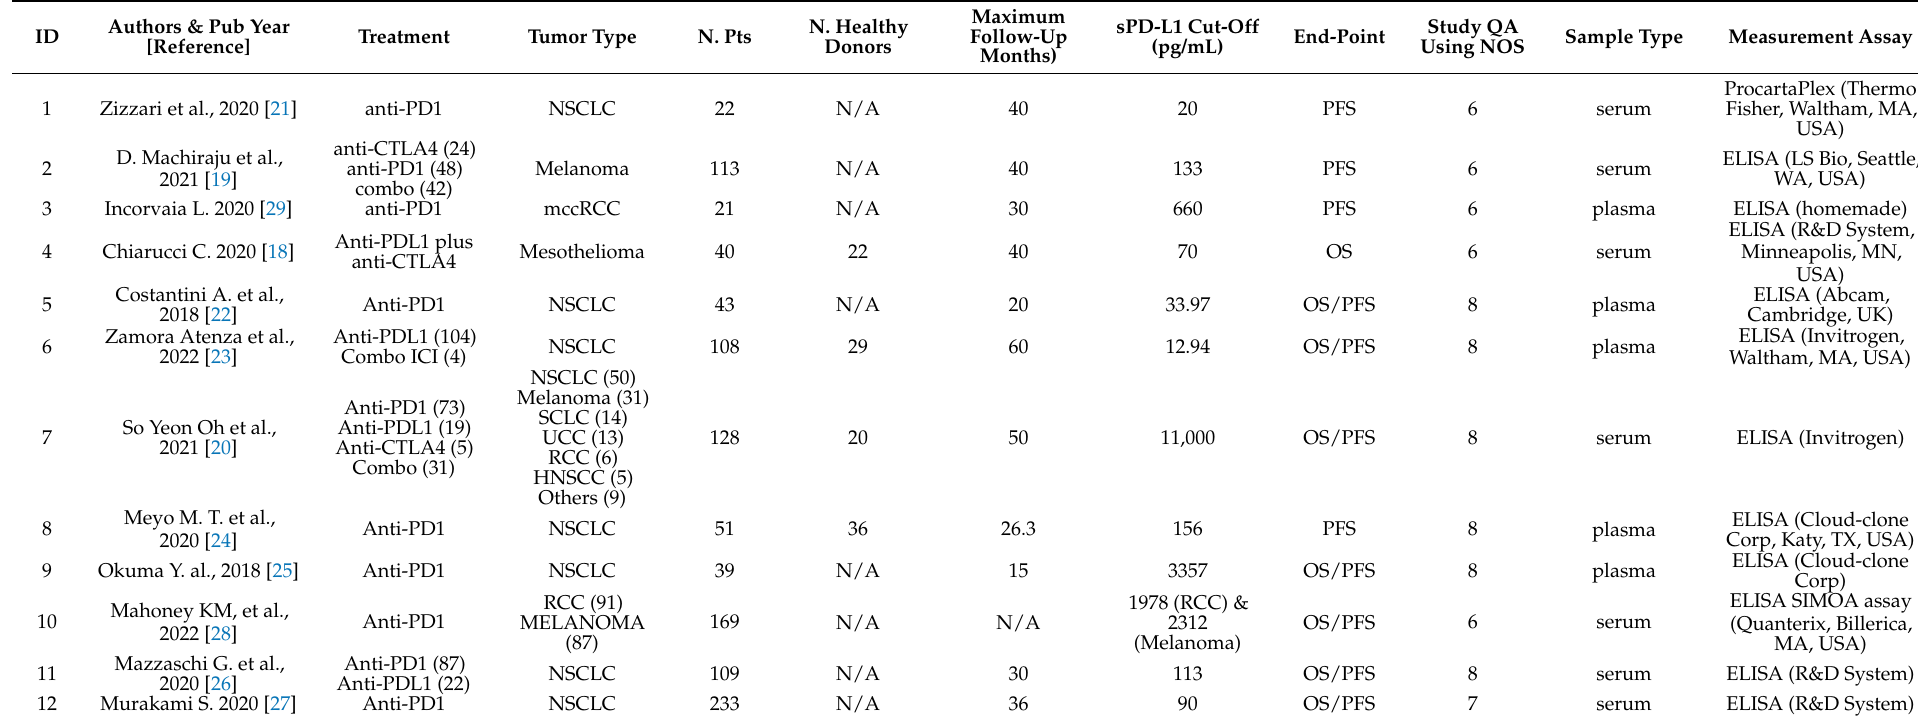
Table 1. Characteristics of the included studies and Quality Assessment (QA) using the Newcastle-Ottawa Scale